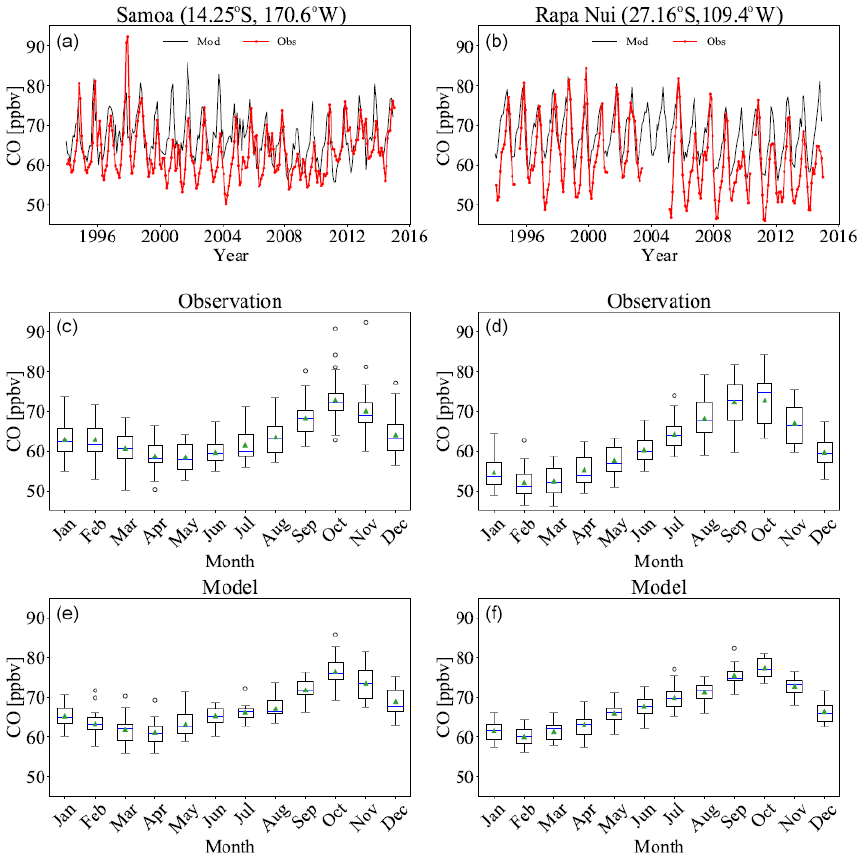
Figure 8. Time series (a, b) of observed (red line) and simulated (blue line) CO volume mixing ratios for Samoa (left) and Rapa Nui (right). The seasonal variability is depicted in box plots as shown by observations (c, d) and the simulation (e, f) for CO for the same stations. Boxes show the 25th to 75th percentiles of the data. Whiskers show the 0th and 100th percentiles, excluding outliers. Circles show outliers, the green triangle is the average, and the blue line is the median of each monthly